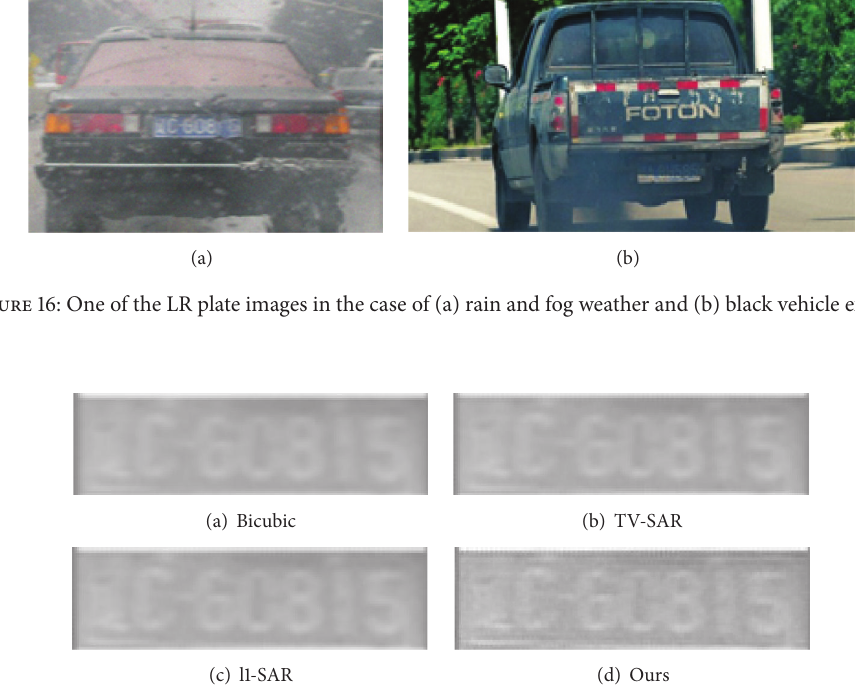
Figure 17: The reconstructed results for the LR license plates obtained under the rain and fog